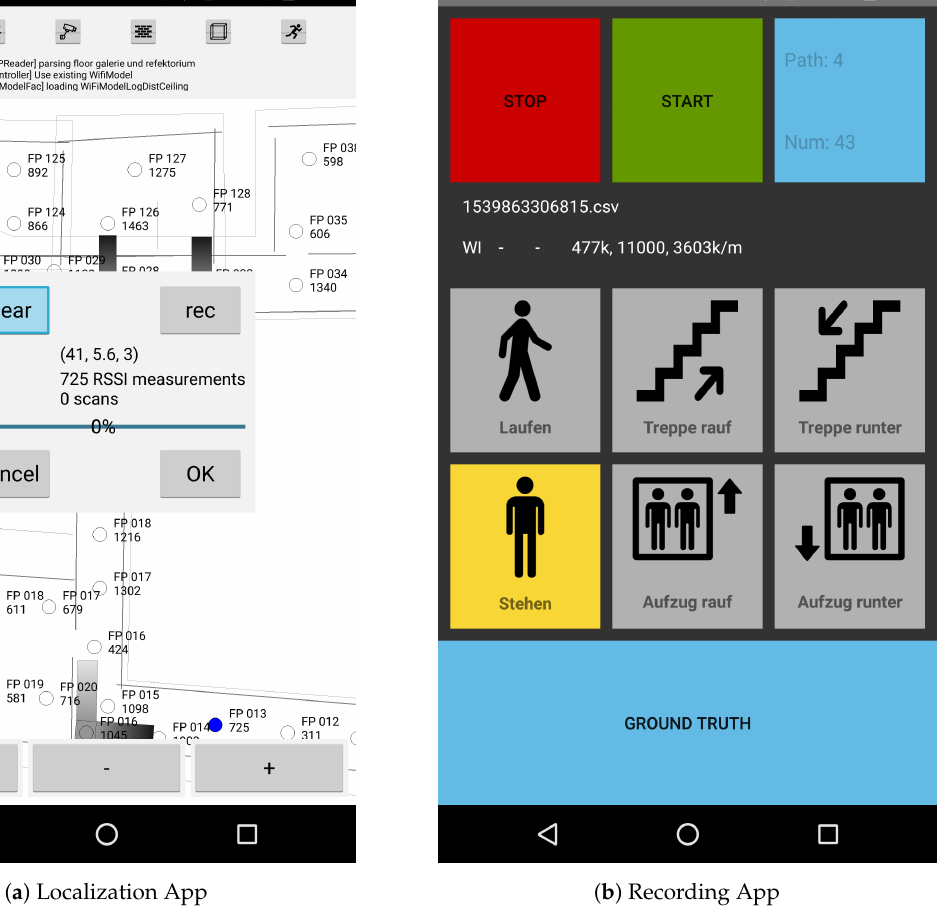
Figure 5. The two mobile applications developed for Android. The localization app in ( a ) is used to record the Wi-Fi reference measurements based on the positions provided by the floor plan. In this screenshot the dialog for recording them is visible. The app also implements the here presented approach and can thus be used for localization. However, for the utilized experiments we used a simpler client ( b ) allowing for user input like a ground truth or activity